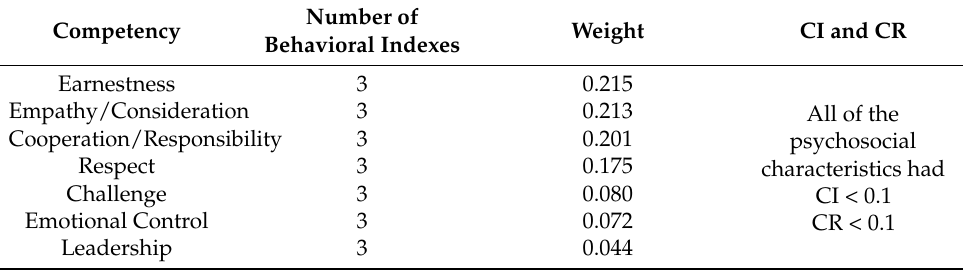
Table 5. The Hierarchical Order of Psychosocial